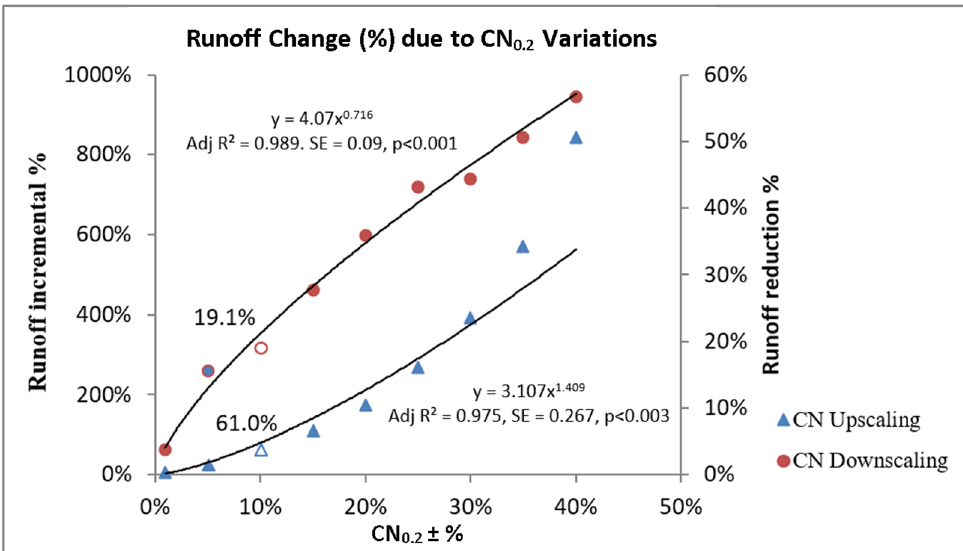
Figure 6. Effects of upscaling and downscaling of CN 0.2 on runoff. CN 0.2 upscaling caused runoff incremental change and vice versa. Note: CN 0.2 upscaling data points refer to primary axis. CN 0.2 variations start from CN 0.2 = 71, variation range (43 to 99) across rainfall depth range from 25 mm to 425 mm. The blank circle and triangular data point are benchmark points of CN 0.2 ± 10%, the indicated 19.1% and 61% are runo ff reduction and incremental due to CN 0.2 variations.